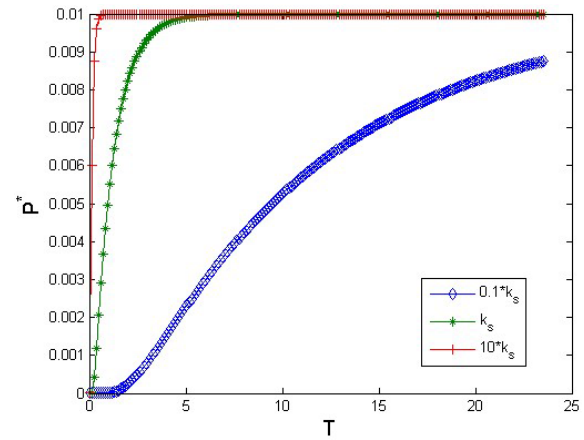
Figure 5. Effect of permeability on the dissipative pore water pres- sure as function of